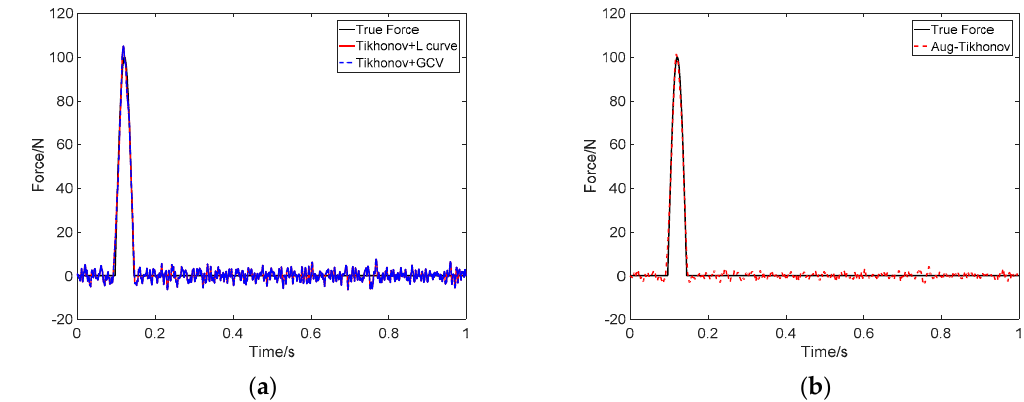
Figure 26. Identification result of impact load at SNR 40 dB on cantilever: ( a ) Tikhonov method; ( b ) the proposed method.